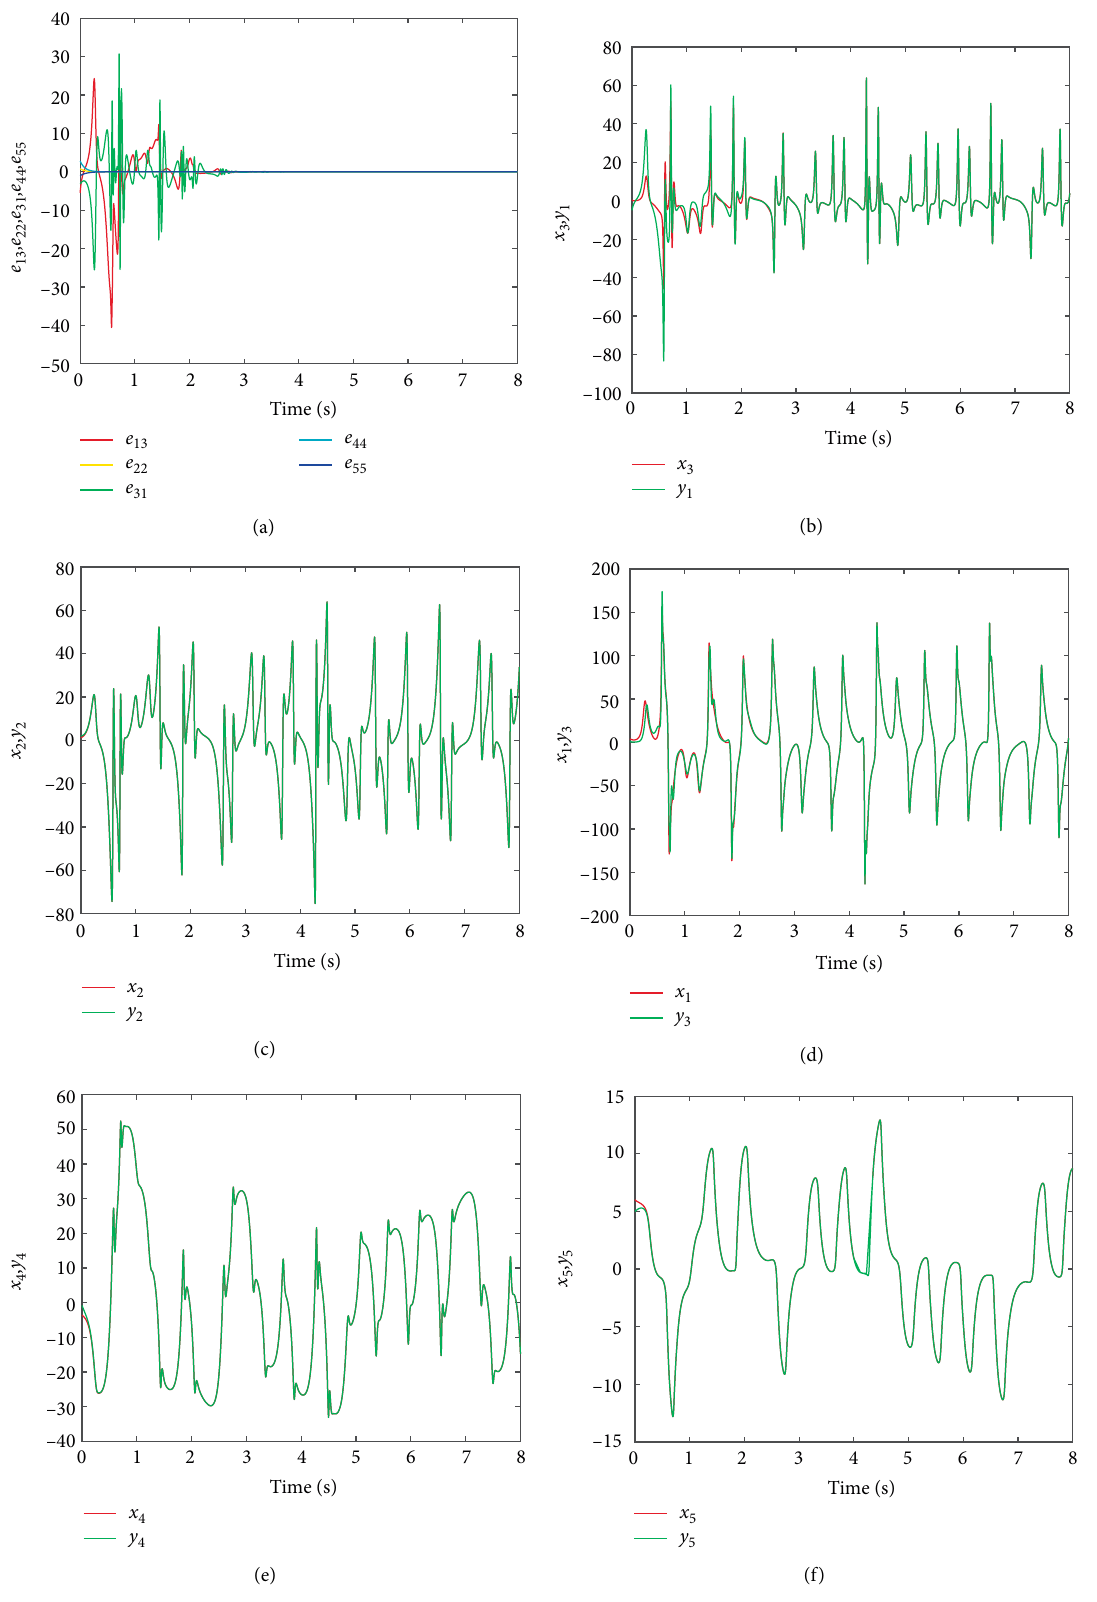
Figure 5: Switch-1: (a) the synchronization error, (b) the error of 𝑥 , (f) the error of 𝑥 𝑥 − 𝑦 4 4